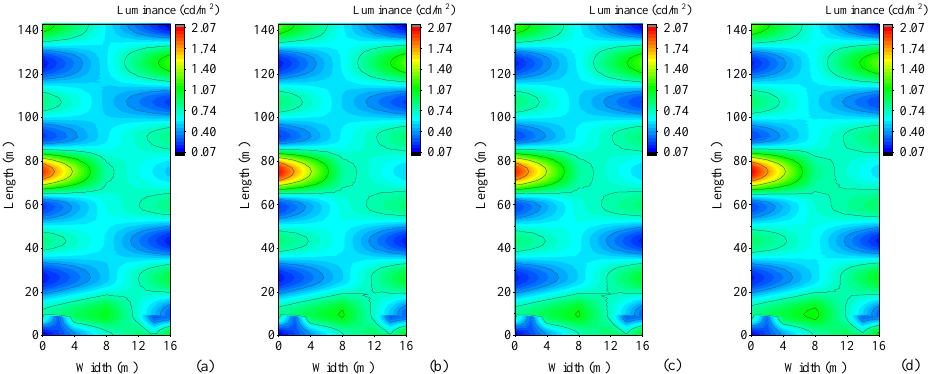
Figure 10. Luminance distributions and corrected mesopic luminance distributions. ( a ) Luminance distributions measured using the 2-degree SSC system, ( b ) conversion to luminance distributions using the 10-degree SSC system, ( c ) corrected mesopic luminance using the 2-degree system, and ( d ) corrected mesopic luminance using the 10-degree system.